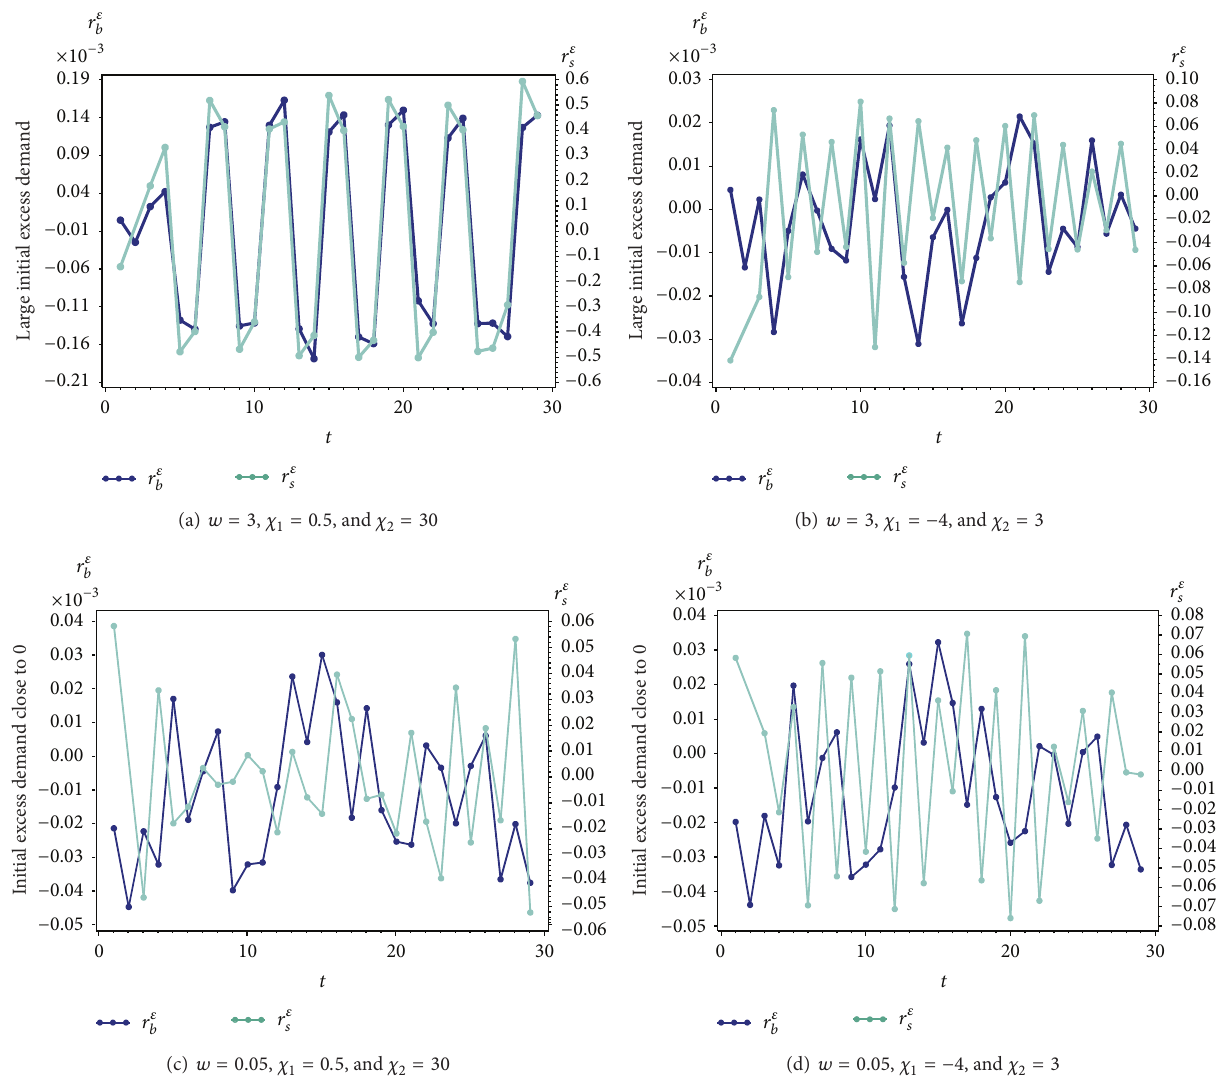
Figure 3: Simulated trajectories of the risky and the low-risk assets. For all plots parameter values are 𝛼 1 = 0 . 02, 𝛼 2 = 0 . 06, 𝜆 = 0 . 05, 𝑌 = 0 . 5, = 0, 𝑃 = 1, 𝑘 = 0 . 20, and 𝜇 = 0 , 15. (a) Prevalence of rational investors ( 𝜒 𝑟 𝑏 ( 𝜒 1 = 0 . 5); (b) prevalence of contrarian speculators ( 𝜒 1 = − 4) and lower importance of rational investors ( 𝜒 2 = 3). (c) and (d) Showing the same market composition as in (a) and (b), but the starting value of the simulation is 𝑤 = 0 . 05